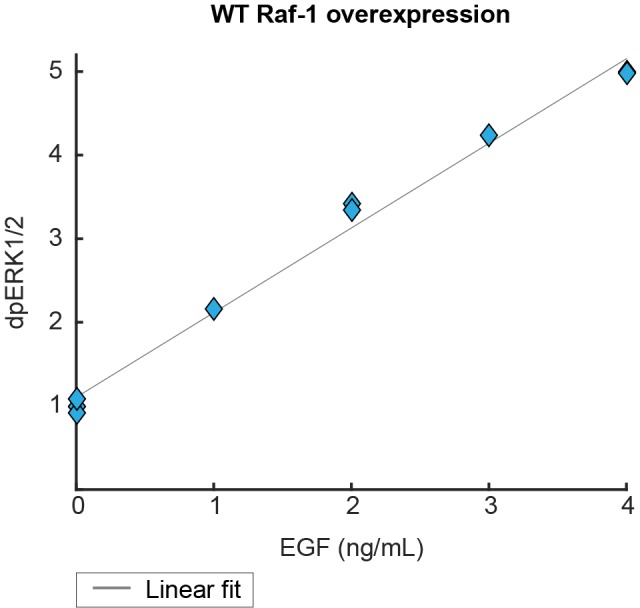
WT Raf-1 overexpression does not affect linear dose-response.H1299 cells over-expressing Raf-1 were treated with the indicated dose of EGF for 5 min, and then assayed for dpERK1/2 by Western blot. The grey line is a fit from a linear model with r2 = 0.99. Data is plotted relative to unstimulated samples, with total N = 9.